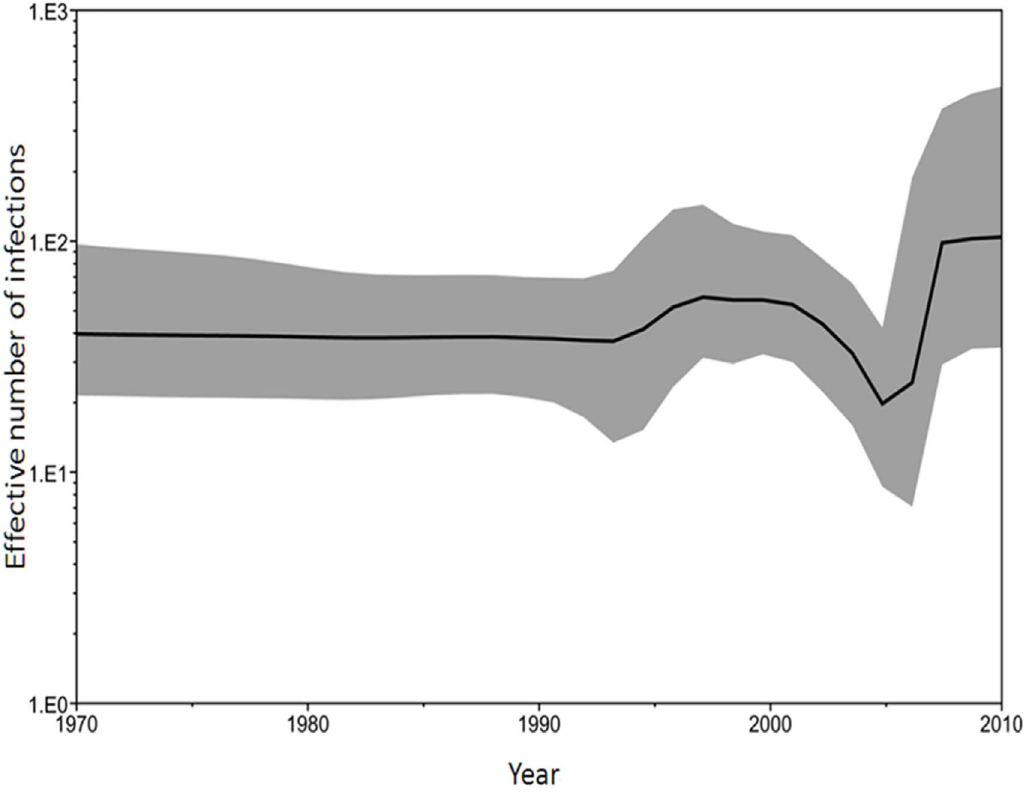
Figure 3. Bayesian skyline plot derived from alignment of the RSV partial F gene sequences in Taiwan. The x axis is in units of years before 2010, and the y axis represents the effective population size of the virus (i.e. the number of genomes effectively contributing to the next generation). The thick solid black line is the estimated median, and the pale gray areas show the upper and lower bounds of the 95% HDP interval. doi:10.1371/journal.pone.0064012.g003 PLOS ONE |